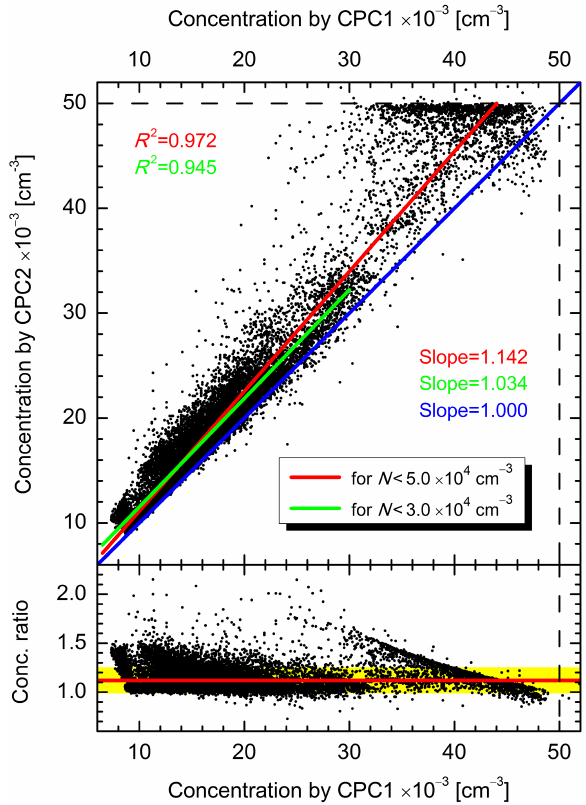
Figure 2. Scatter plot and CPC2 / CPC1 concentration ratios for the data obtained by two identical CPCs. In the upper panel, the coefficients of determination of the data pairs ( R 2 ), the regression lines and their slopes are shown for concentrations N <5 . 0 × 10 4 and <3 . 0 × 10 4 cm − 3 in the corresponding colours, together with the equality line. In the lower panel, the horizontal red line and yel- low band indicate the mean concentration ratio and its standard de- viation,